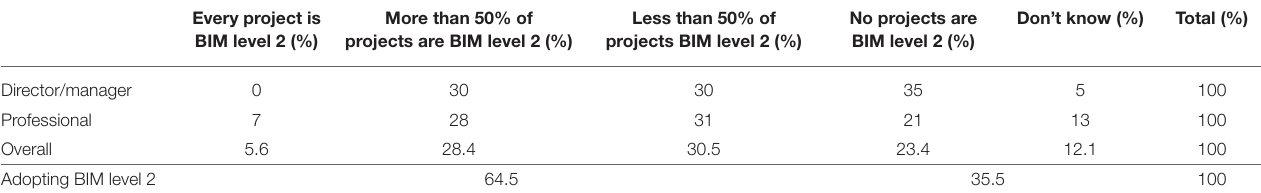
TABLE 5 | BIM level 2 adoption.